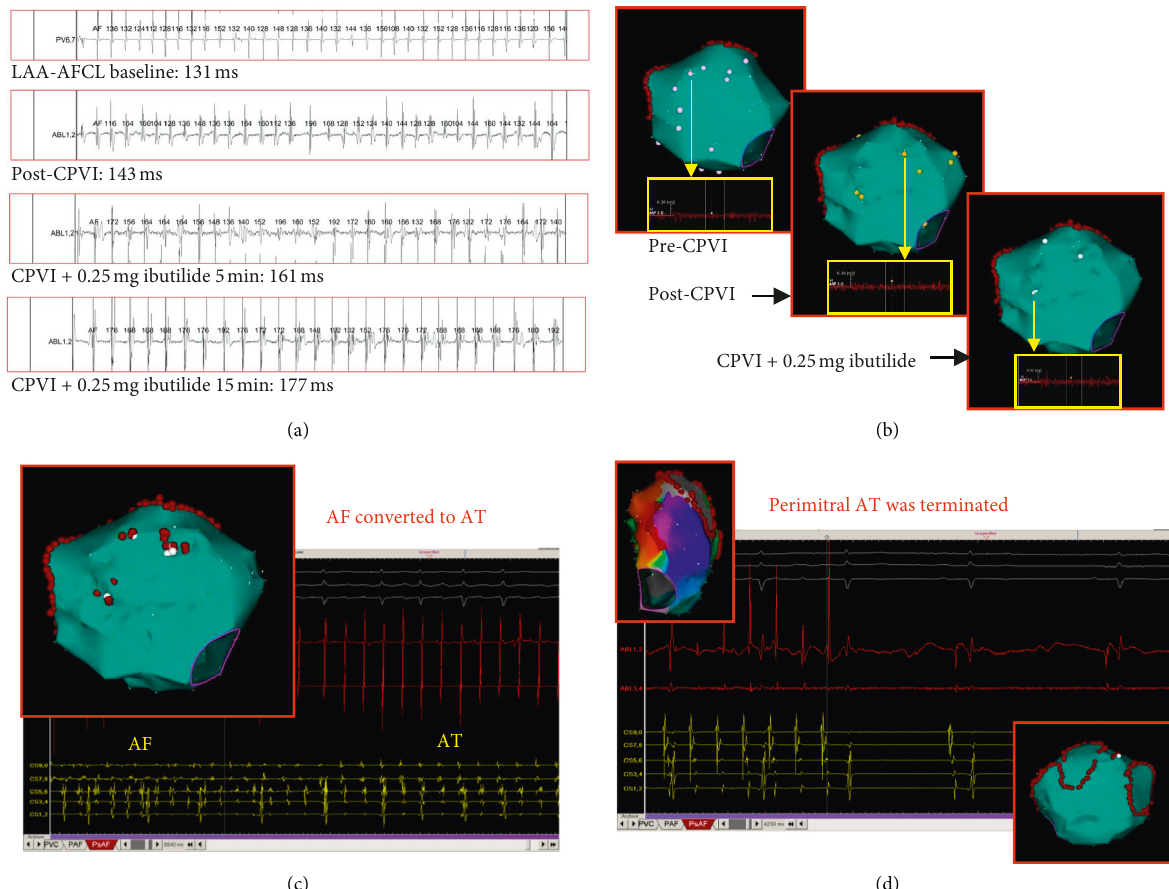
Figure 3: An example of persistent atrial fibrillation (AF) ablation with this low-dose ibutilide-guided approach. (a) The AF cycle length (AFCL) within the left atrial appendage (LAA) at baseline, after circumferential pulmonary vein isolation (CPVI), and 5 and 15 minutes after administration of 0.25 mg ibutilide. (b) Three electroanatomic maps showing the sites where low-amplitude complex fractionated atrial electrograms (CFAEs) were recorded on the anterior wall of the left atrium (LA). The pink, yellow, and white points represent CFAEs recorded before CPVI, after CPVI, and after administration of 0.25 mg ibutilide, respectively. The CFAE areas were minimized after CPVI plus ibutilide. (c) Ablation targeting these areas converted AF to atrial tachycardia (AT). (d) The 3D electroanatomic mapping of LA suggested that the mechanism of this AT was perimitral reentrant tachycardia (left upper), and ablation (alone) at the mitral isthmus terminated this